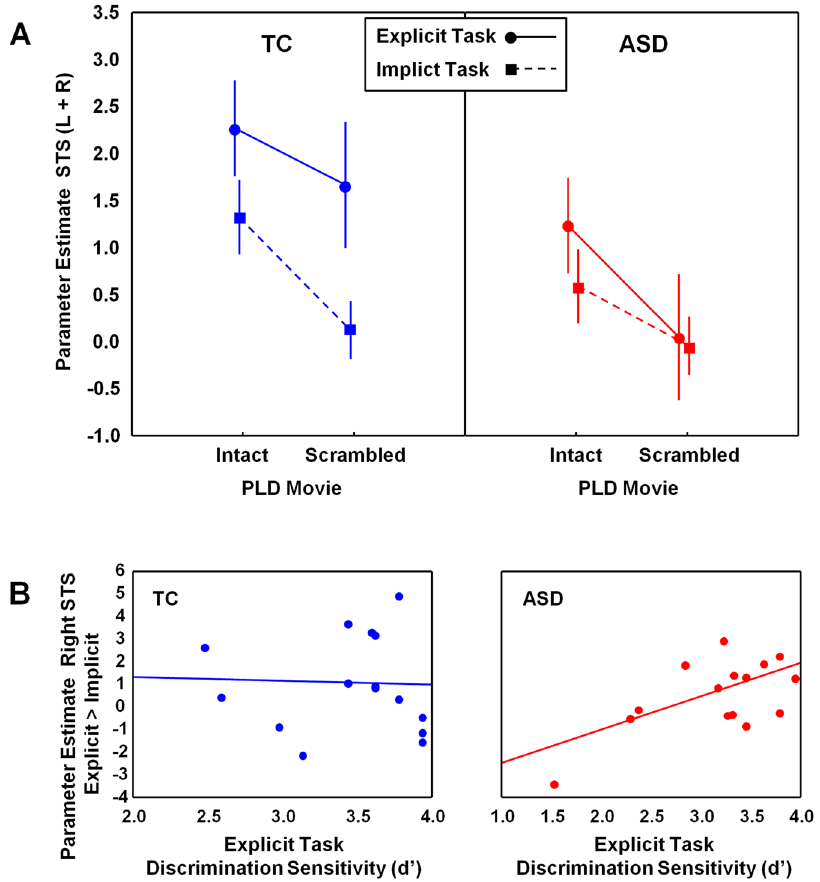
Figure 3. Regional analysis of task-related brain activity during biological motion processing in bilateral STS. Panel A visualizes for each group (ASD, TC) parameter estimates of task-related brain activity ( > fixation) in bilateral STS during explicit and implicit biological motion processing, separately for intact and scrambled PLDs. Panel B visualizes for each group (ASD, TC) the relationship between discrimination sensitivity (d’) and right STS parameter estimates of task-related brain activity for explicit biological motion processing ( > implicit). Vertical bars denote + / − standard